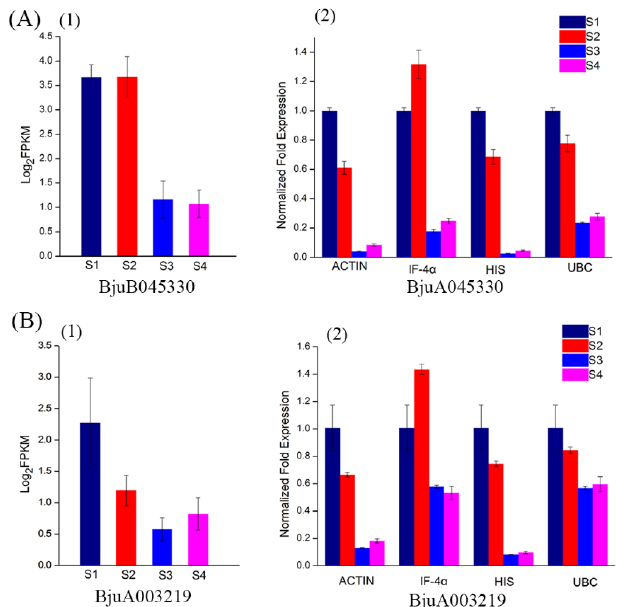
Figure 7. Transcript abundance and qPCR analysis of BjuB045330 and BjuA003219 at different stages of development. ( A ) Transcript abundance ( 1 ) and relative expression level ( 2 ) of BjuB045330 . ( B ) Transcript abundance ( 1 ) and relative expression level ( 2 ) of BjuA003219 . FPKM values were log2 ‐ based.